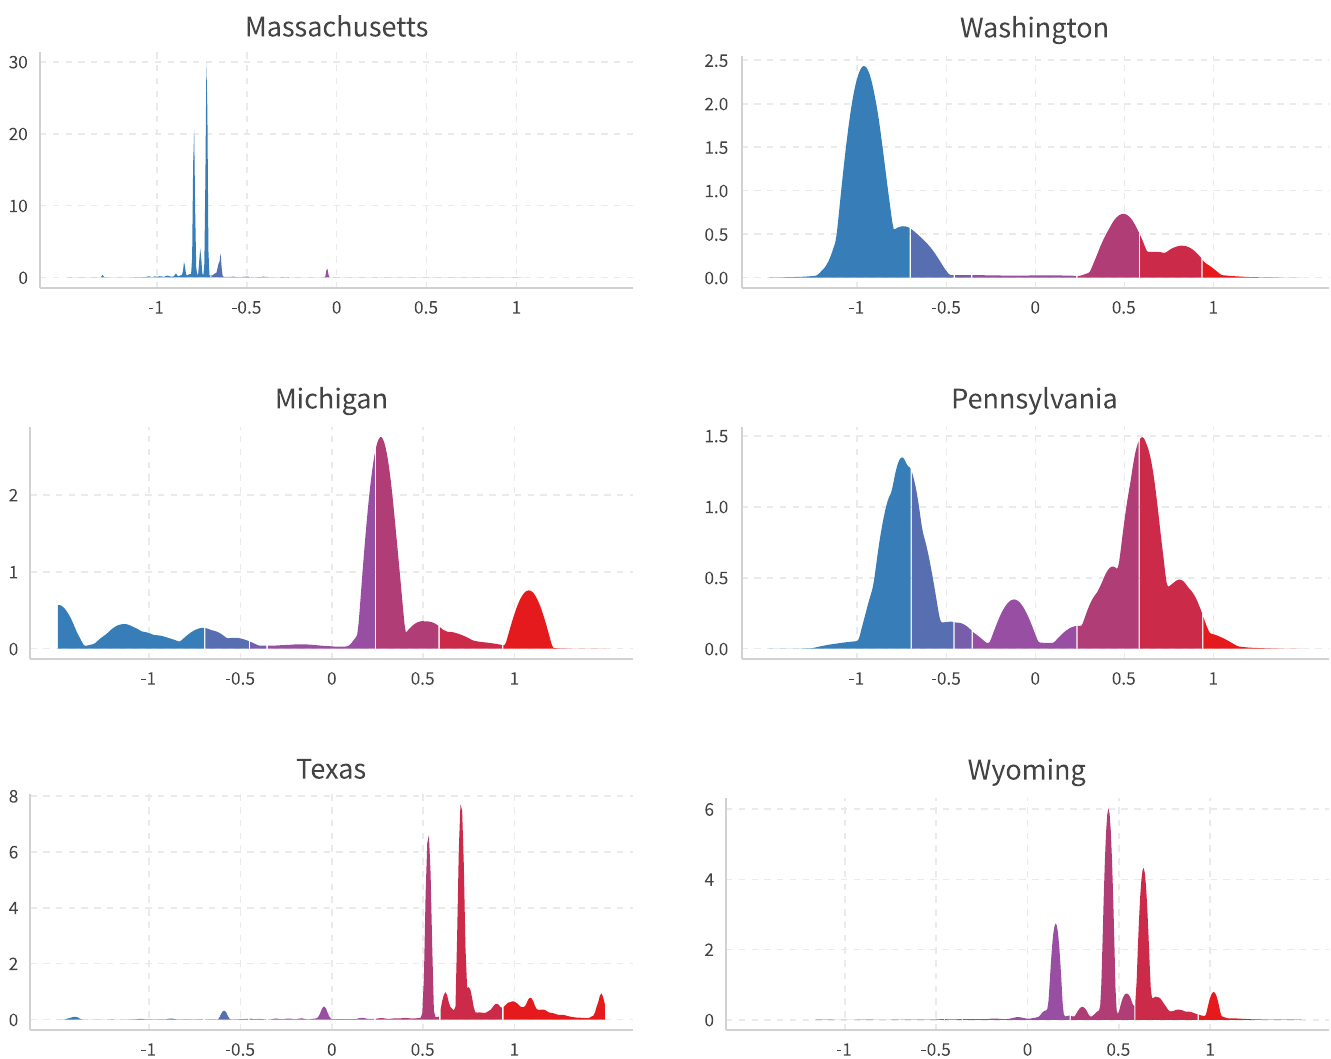
Fig 9. Users in selected states, politician-only method [1]. This figure shows user ideology estimate using only politician pages [1]. States are guessed by the maximum state on likes of national politicians (Sen, Rep, Gov). Colors represent matching densities with self-reported ideology shares in 2016 General Social Surveys